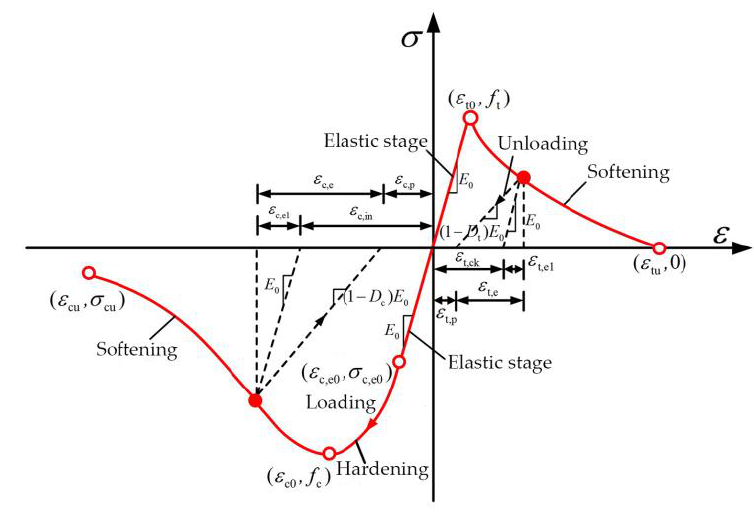
Figure 23. Stress–strain curves of CDP. Figure 23. Stress – strain curves of CDP.